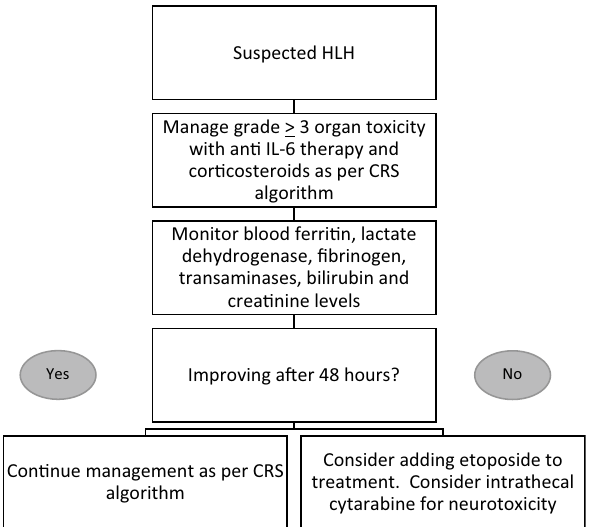
Fig. 1 Recommendations for the management of CAR-T cell related Hemophagocytic Lymphohistiocytosis (HLH) /Macrophage Activa- tion Syndrome (MAS)